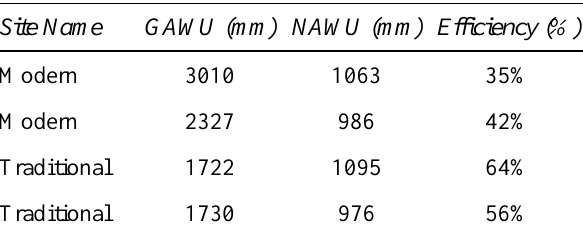
Table 3: Summary of water use 2000/2001 season (wet